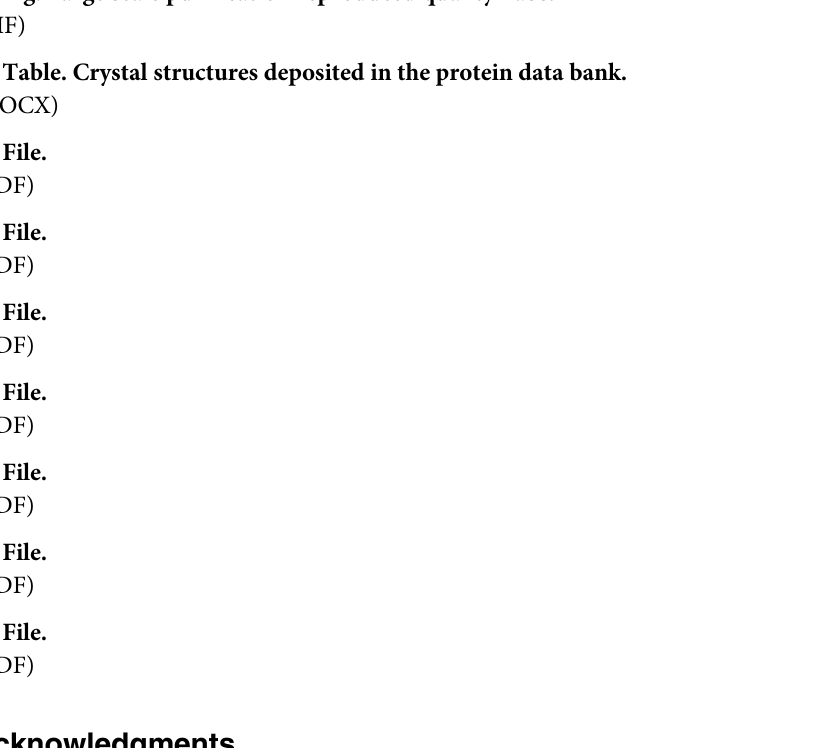
S2 Fig. Large scale purification reproduced quality Fabs. S1 Table. Crystal structures deposited in the protein data